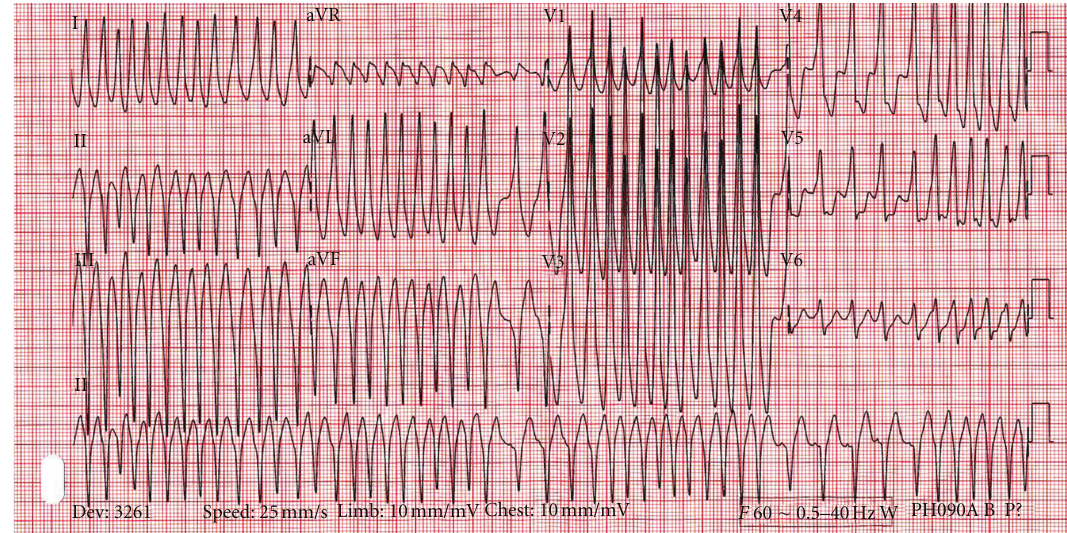
Figure 1: EKG showing atrial fibrillation with rapid ventricular response in the setting of Wol ff -Parkinson-White disease.